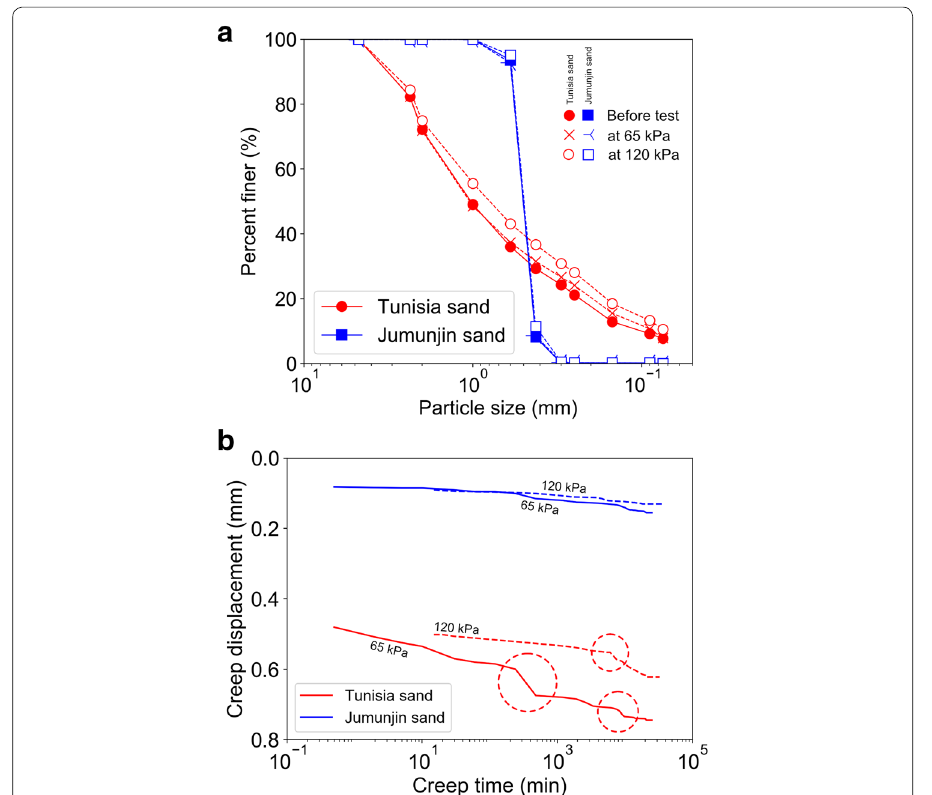
Fig. 1 Creep behaviors of Tunisia and Jumunjin sands at low stresses: a Change in particle size distribution curve; b Creep displacement during